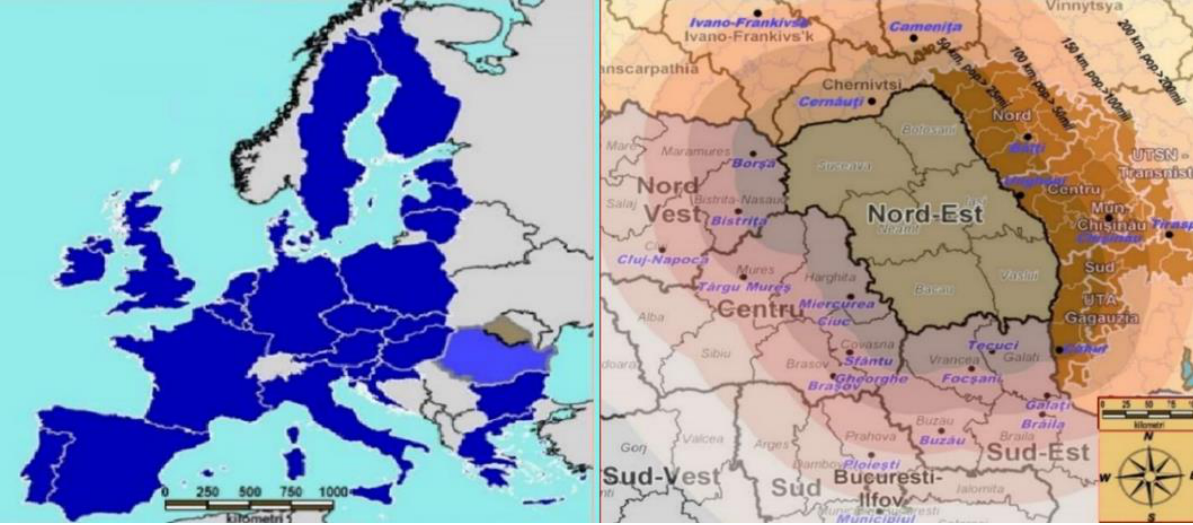
Figure 2. Geographical location of the NEDR of Romania. Image processing after: (ADRNE 2020).